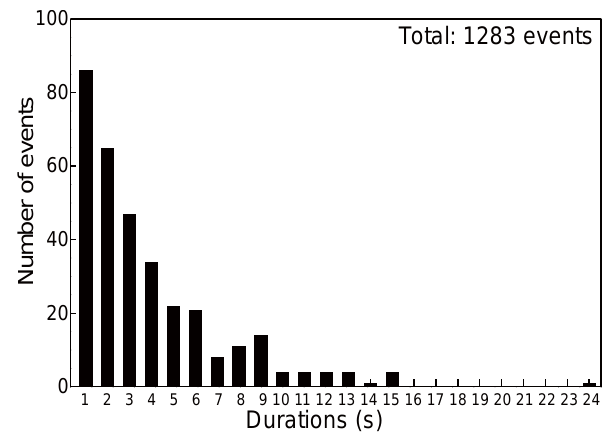
Figure 5. Distribution of duration time for severe magnetic fluctua- tion